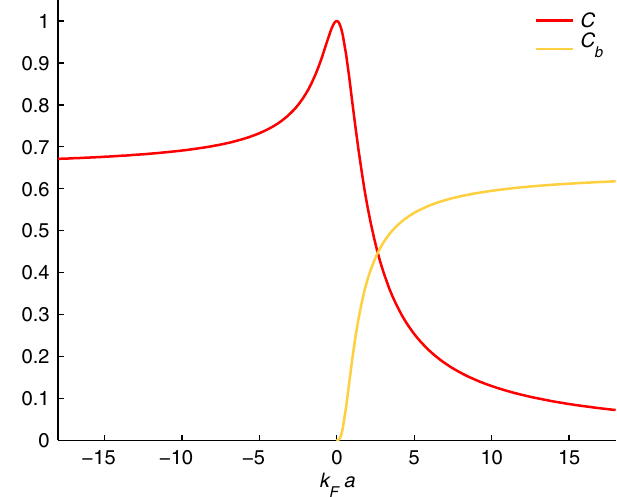
FIG. 5. The prefactors that appear in the asymptotic behavior of the overlap function, as well as in the RF response near the ; ! thresholds at ! b ; see Eqs. (12) and (15)–(17). The prefactors 0 were obtained from the asymptotic form of the numerically evaluated overlap